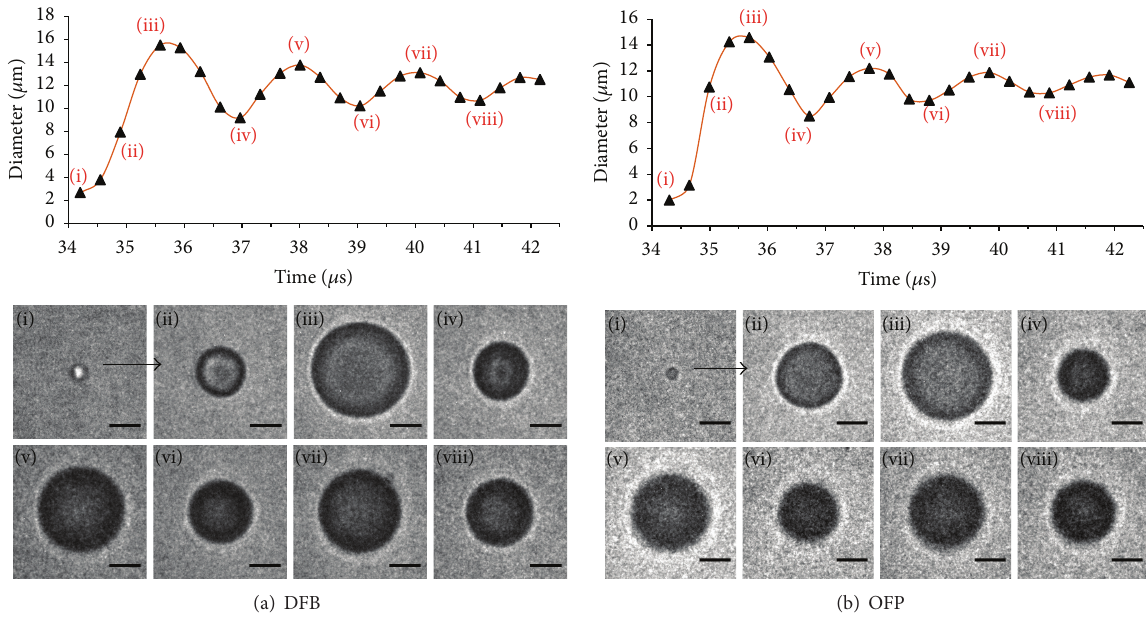
Figure 8: Vaporization and expansion properties of volatile PFC droplets vaporized with a 2-cycle sinusoid at 8 MHz. (a) A DFB droplet near 2.7 𝜇 m in diameter vaporizes and expands to a maximum near 15.5 𝜇 m in diameter within 2 𝜇 s and eventually settles to a smaller resting diameter. (b) An OFP droplet near 2 𝜇 m in diameter expands to a maximum near 14.6 𝜇 m in diameter and settles to a smaller resting diameter. In both cases, the droplet oscillations occurred over the course of 10 𝜇 s after vaporization. Scale bar represents 5 𝜇 m. Reproduced from [93] with permission from the Institute of Physics in Engineering and